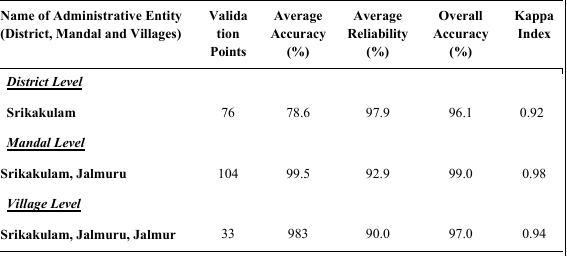
Table 1. Summary of validation points and accuracy assessment of satellite-based rice area estimates in Srikakulam District.